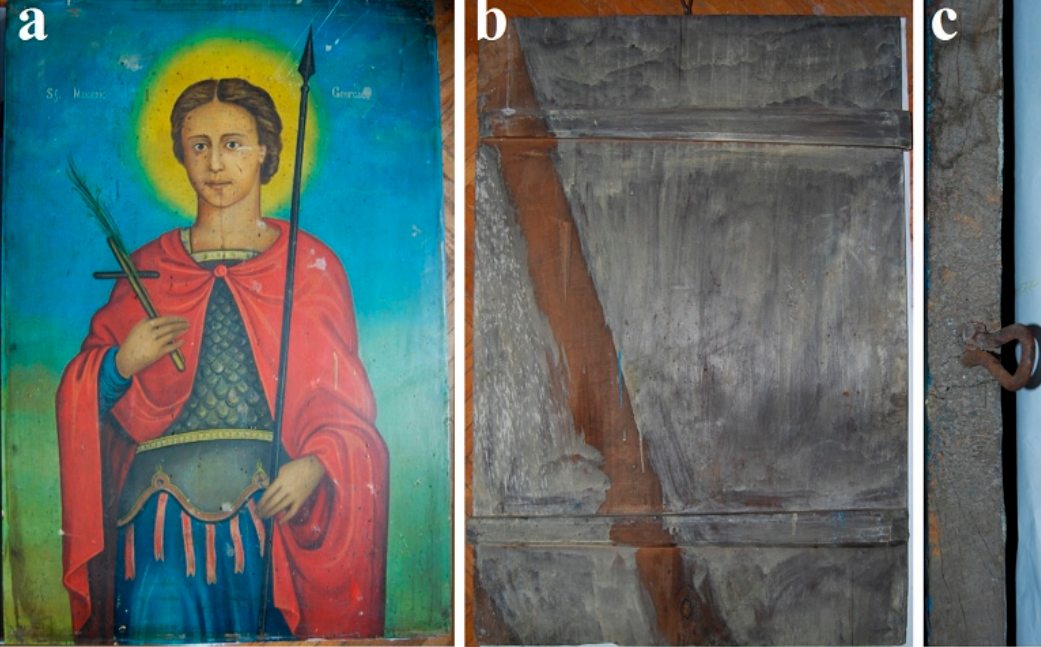
Figure 1. The icon “Saint George” ( a )—front, ( b )—back; ( c )—icon top edge.